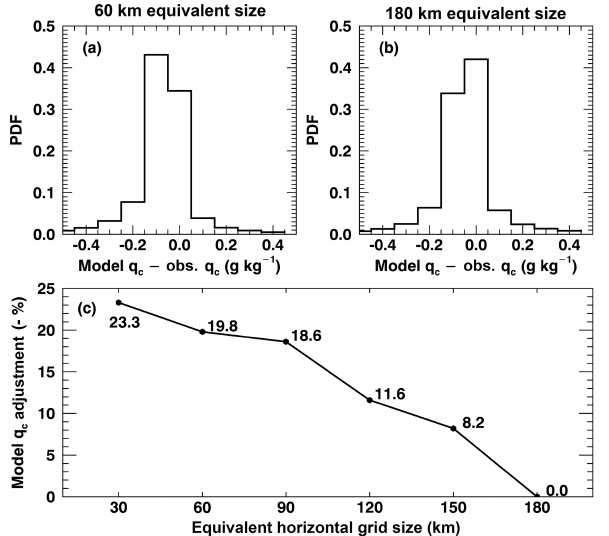
Figure 5. q c needed for models to adjust to reach the same auto- conversion rate as observations for (a) 60km and (b) 180km model equivalent sizes. Positive biases represent increased q c required in models, and negative biases mean decreased q c . The average per- centages of adjustments for different equivalent sizes are shown in panel (c) . Note that the percentages in the vertical axis are negative.